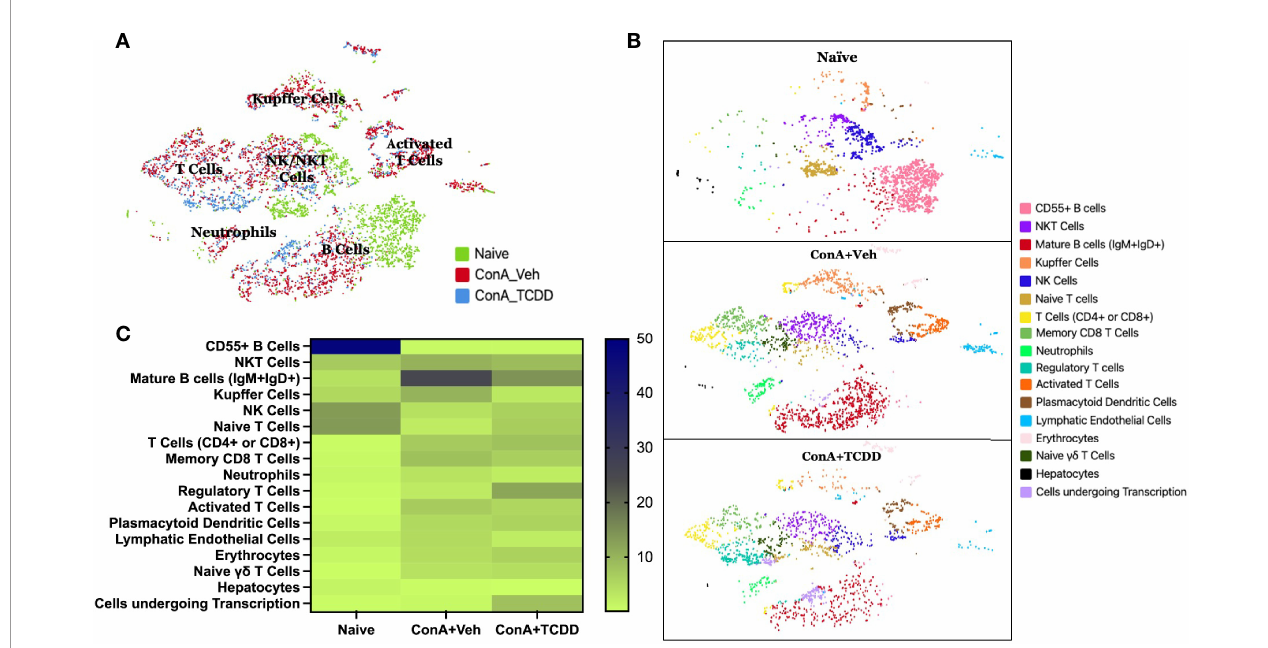
FIGURE 3 | Identi fi cation of changes in cellular types following ConA-induced hepatitis using scRNA-seq. C57/BL6 mice were injected with ConA followed by vehicle or TCDD 1 hour later as described in Figure 1 legend. Liver in fi ltrating cells were isolated and scRNA-seq was performed as described in Methods. (A) tSNE plot with each treatment group separated by color and main clusters labeled. (B) tSNE plot separated by sample group and colored to show varying stages of activation and differentiation (C) Heatmap of the percentages of cells contained in each tSNE cluster with the increases in the percentage shown by the change in color from light to dark.